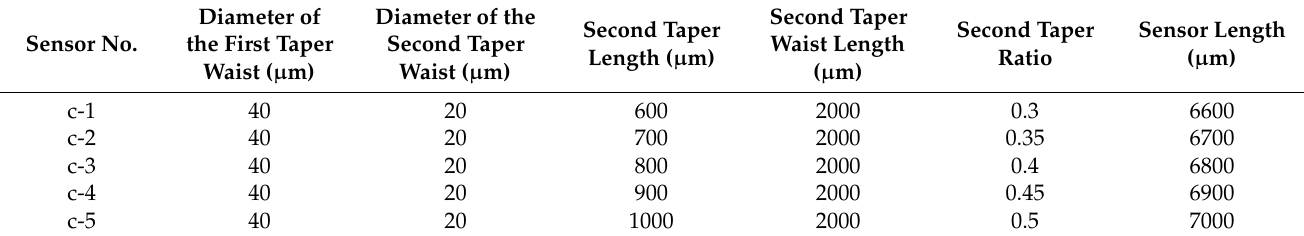
Table 2. Tapered fiber sensors with different second taper ratios.